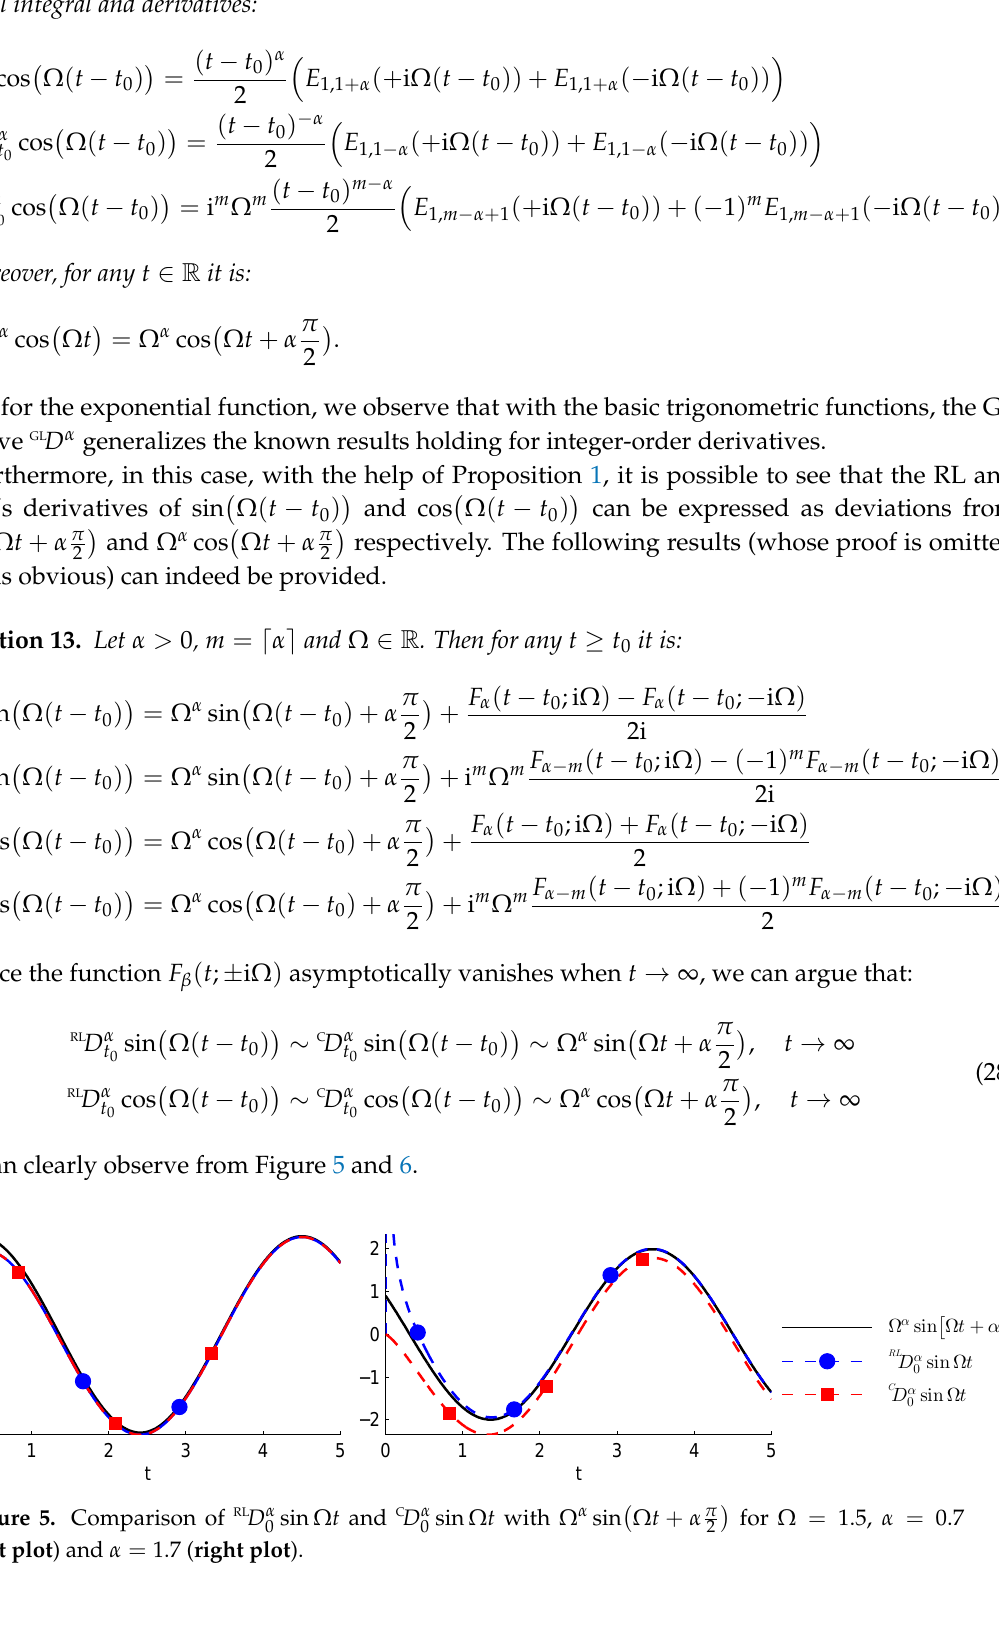
Figure 5. Comparison of RL D α ( left plot ) and α = 1.7 ( right plot